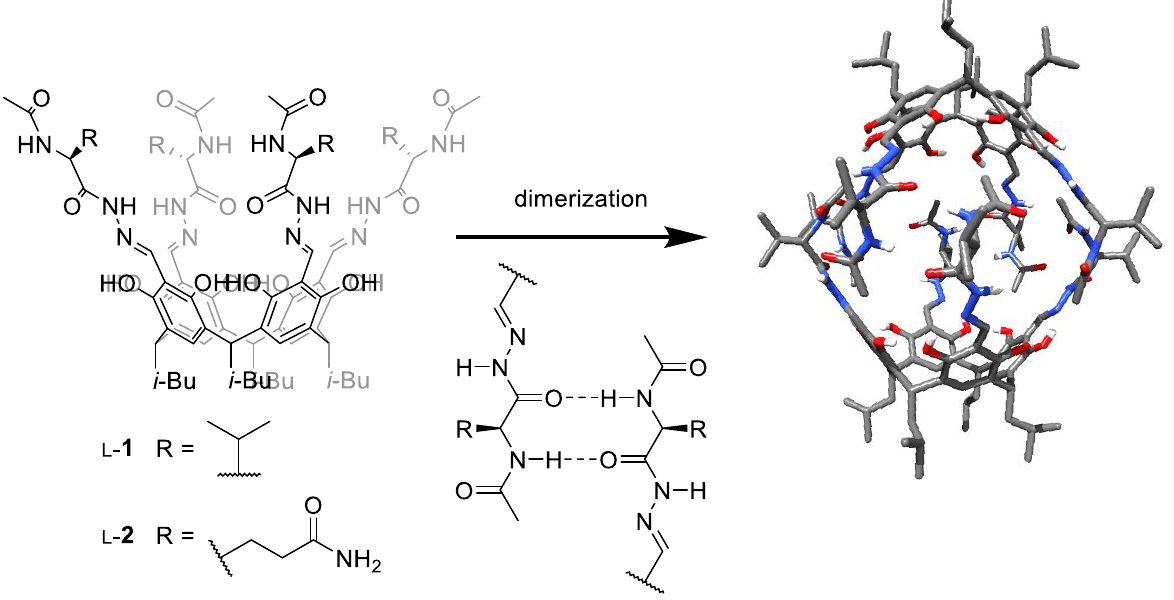
Figure 1. The structures of cavitands used in this study ( L - 1 and L - 2) , the dimerization process, and the X-ray structure of dimer ( L - 1 ) 2 (from ref. [12]).